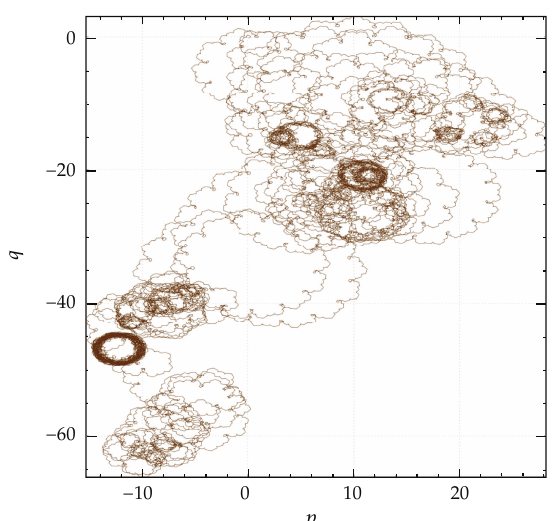
Figure 4: The weakly chaotic orbit at E (cid:7) 0 . 21 (cid:5) in fifth-order Hamiltonian (cid:6) on the (cid:5) p,q (cid:6) -plane.